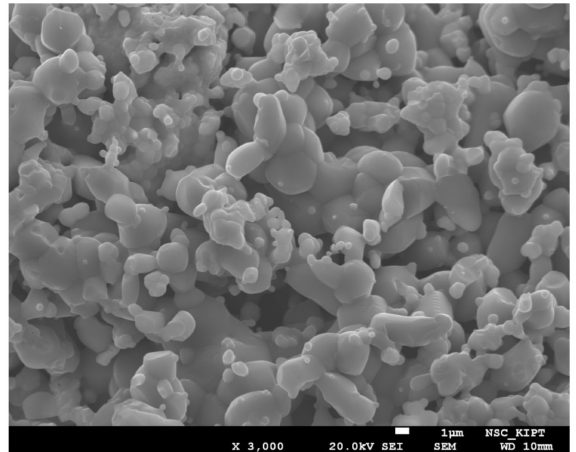
Figure 5. SEM image of Y 2 Ti 2 O 7 sample after conventional heat treatment for 7 h, and 1 h microwave-assisted